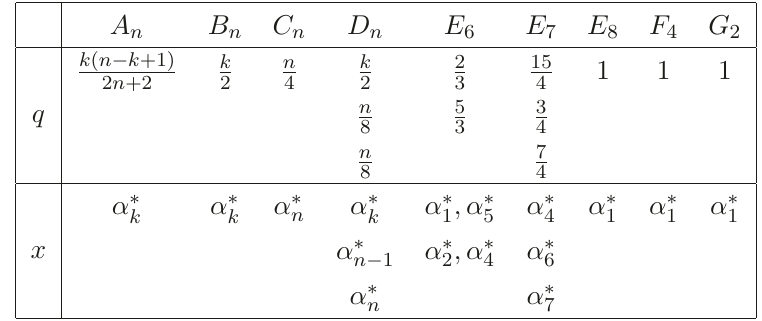
Table 2 . This table lists for every simple Lie algebra the charges q associated to the coweights x . q is defined by c 2 ( B x ) = qH 2 on C P 3 . The coweights that are not listed are associated to integer charges. The coweights are expressed in the basis dual to the root basis. The ordering of the roots is standard and follows appendix 13.A of [67]. The indices ranges are n